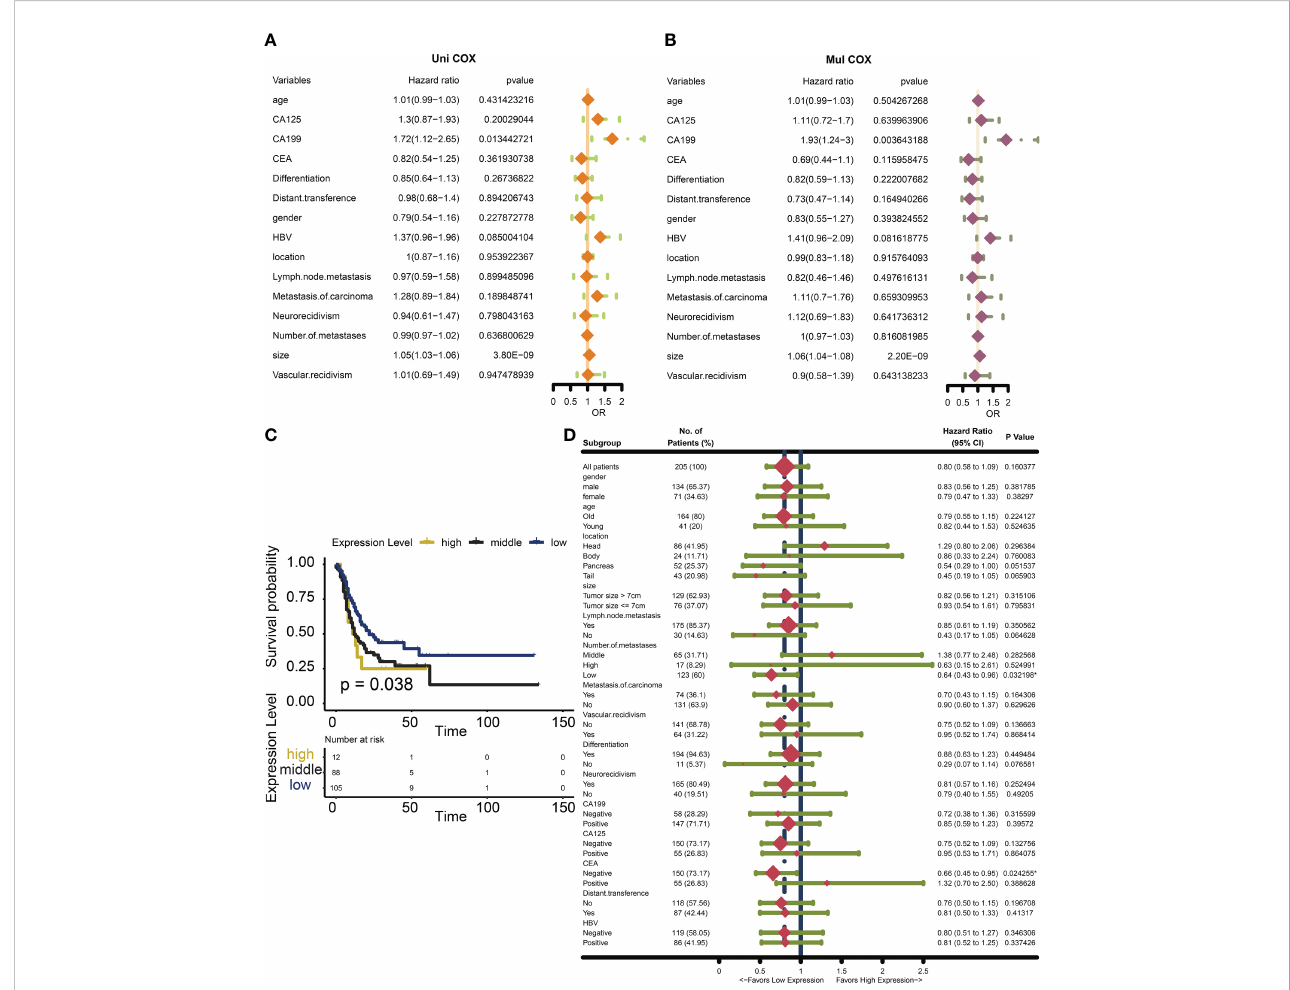
FIGURE 3 Survival analysis and Subgroup analysis of NOX4 in clinicopathologic features of pancreatic cancer. (A) Univariate Cox analysis of clinicopathologic features in patients with pancreatic cancer. (B) Multivariate Cox analysis of clinicopathologic features in patients with pancreatic cancer. (C) Kaplan-Meier curves of different NOX4 expression levels. (D) Subgroup analysis of NOX4